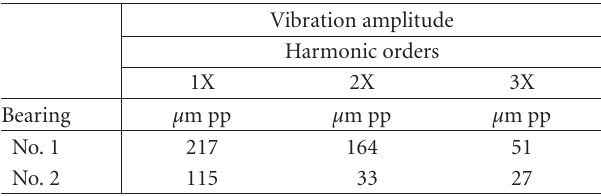
Table 1: Amplitude of the first three harmonic orders of the shaft vibrations measured on the bearings #1 and #2 at 1720 rpm during the first aborted